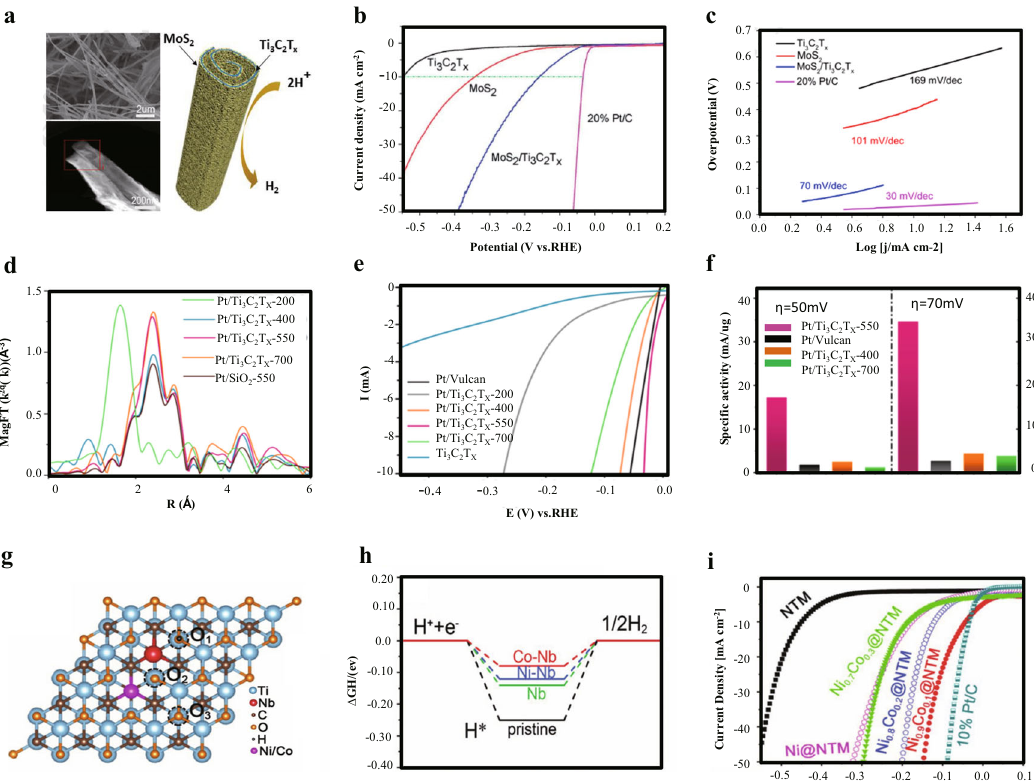
Fig. 10 MXenes-based HER electrocatalysts optimized by hybridization. a Illustration of the ‘ nanoroll ’ -like MoS 2 /Ti 3 C 2 T x composite. b Polarization curves and c Tafel plots of MoS 2 /Ti 3 C 2 T x composite, pristine MoS 2 and Ti 3 C 2 T x nanosheets 101 . Copyright 2019, Elsevier. d In-situ X-ray absorption spectroscopy. e HER polarization curves at 2 mV s − 1 in H 2 saturated 0.1 M HClO 4 . f Speci fi c activity of the Pt/Vulcan and Pt/ Ti 3 C 2 T x catalysts, which was normalized by H 2 chemisorption at − 60 °C 117 . Copyright 2019, American Chemical Society. g Atomic con fi guration of Co/Ni replaced Ti atom on Nb-doped monolayer Ti 3 C 2 O 2 and the three different O sites for H* adsorption. h Δ G H for H* adsorbed at active site on M-doped Ti 3 C 2 O 2 monolayer. i HER polarization curves of the NiCo@NTM nanohybrids, Ni@NTM nanohybrid, NTM, and 10% Pt/C in 1 M KOH 114 . Copyright 2019,